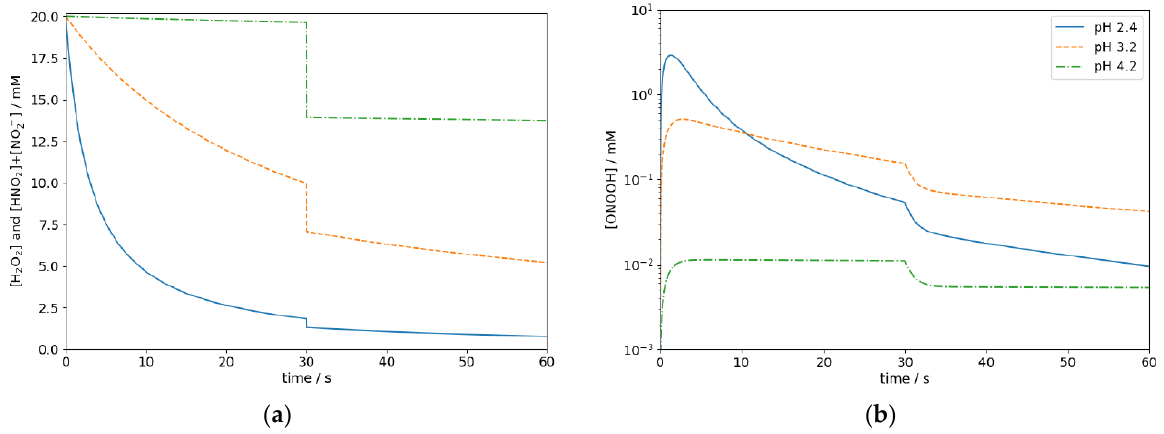
Figure 5. Computed concentrations of H 2 O 2 ≙ HNO 2 + NO 2 − and ( a ) ONOOH ( b ) at pH 2.4, 3.2, and 4.2 at initial concen-